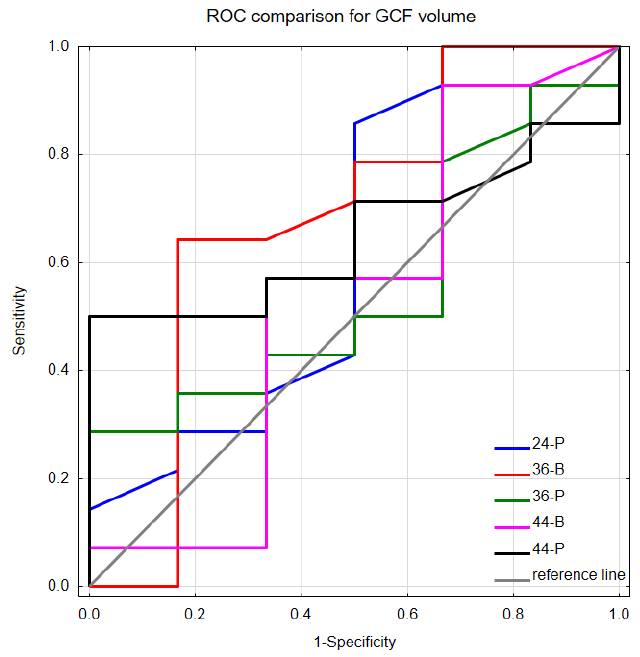
Figure 4. ROC curves for gingival crevicular fluid volume (B, buccal/labial; P, palatal/lingual). Table 4. Results of ROC analysis for gingival crevicular fluid volume.